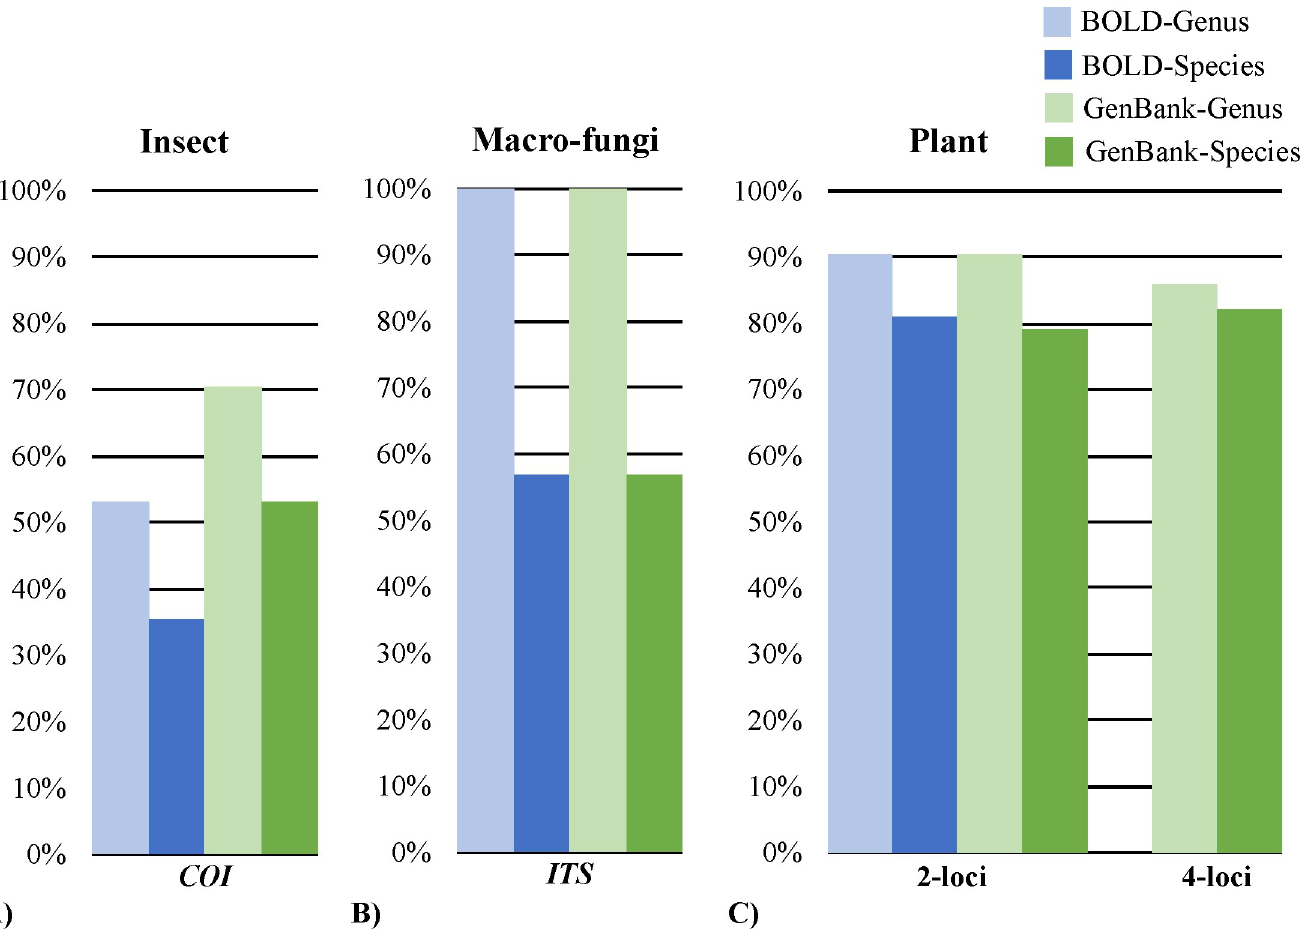
Fig 1. Overall classification accuracies from BOLD and GenBank for: A) COI insect sequences (n = 17), B) ITS macro-fungi sequences (n = 14), and C) plant taxa using either a 2-locus ( rbcL and matK ; n = 53) and 4-locus approach ( rbcL , matK , trnH-psbA and ITS2 ; n = 28). The identification success for genus is denoted by the light color and species by the dark color. Blue bars correspond to results from searches against BOLD and green against GenBank.